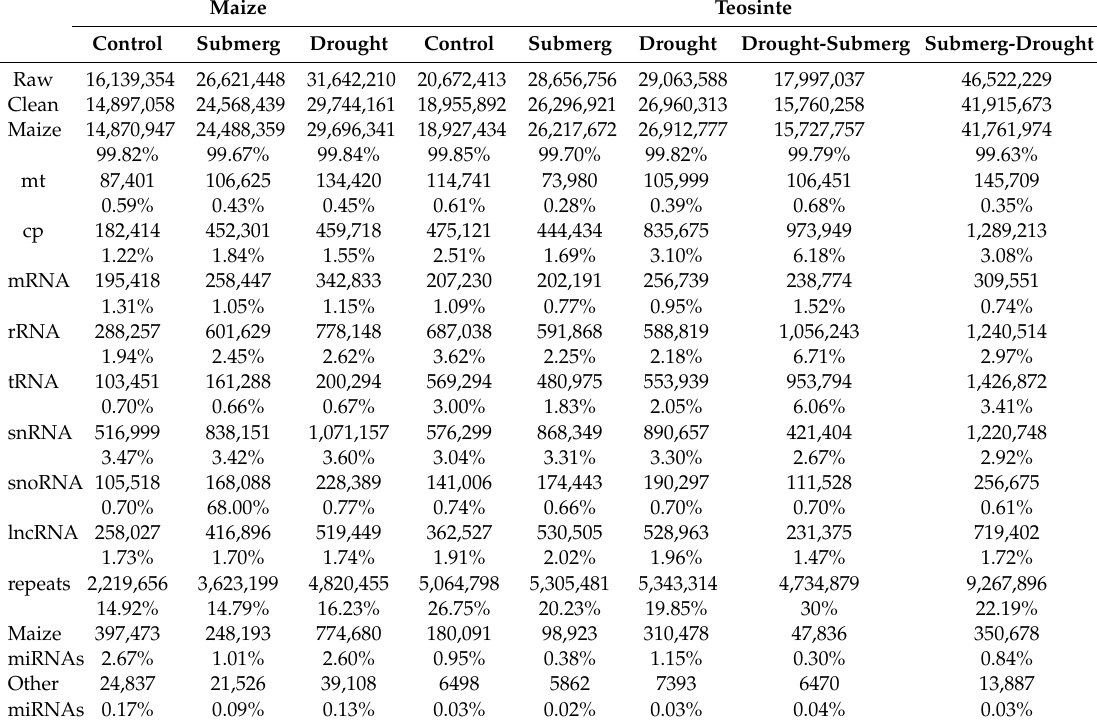
Table 1. Summary of small RNA sequencing data from eight maize and teosinte libraries. Distribution of small RNAs in the corresponding non-coding RNA